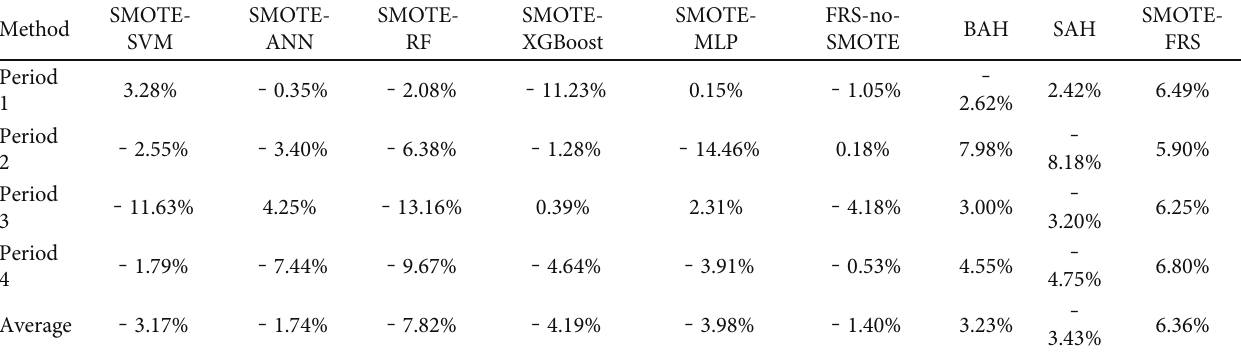
Table 9: The accumulated return results of the benchmarks and the proposed method